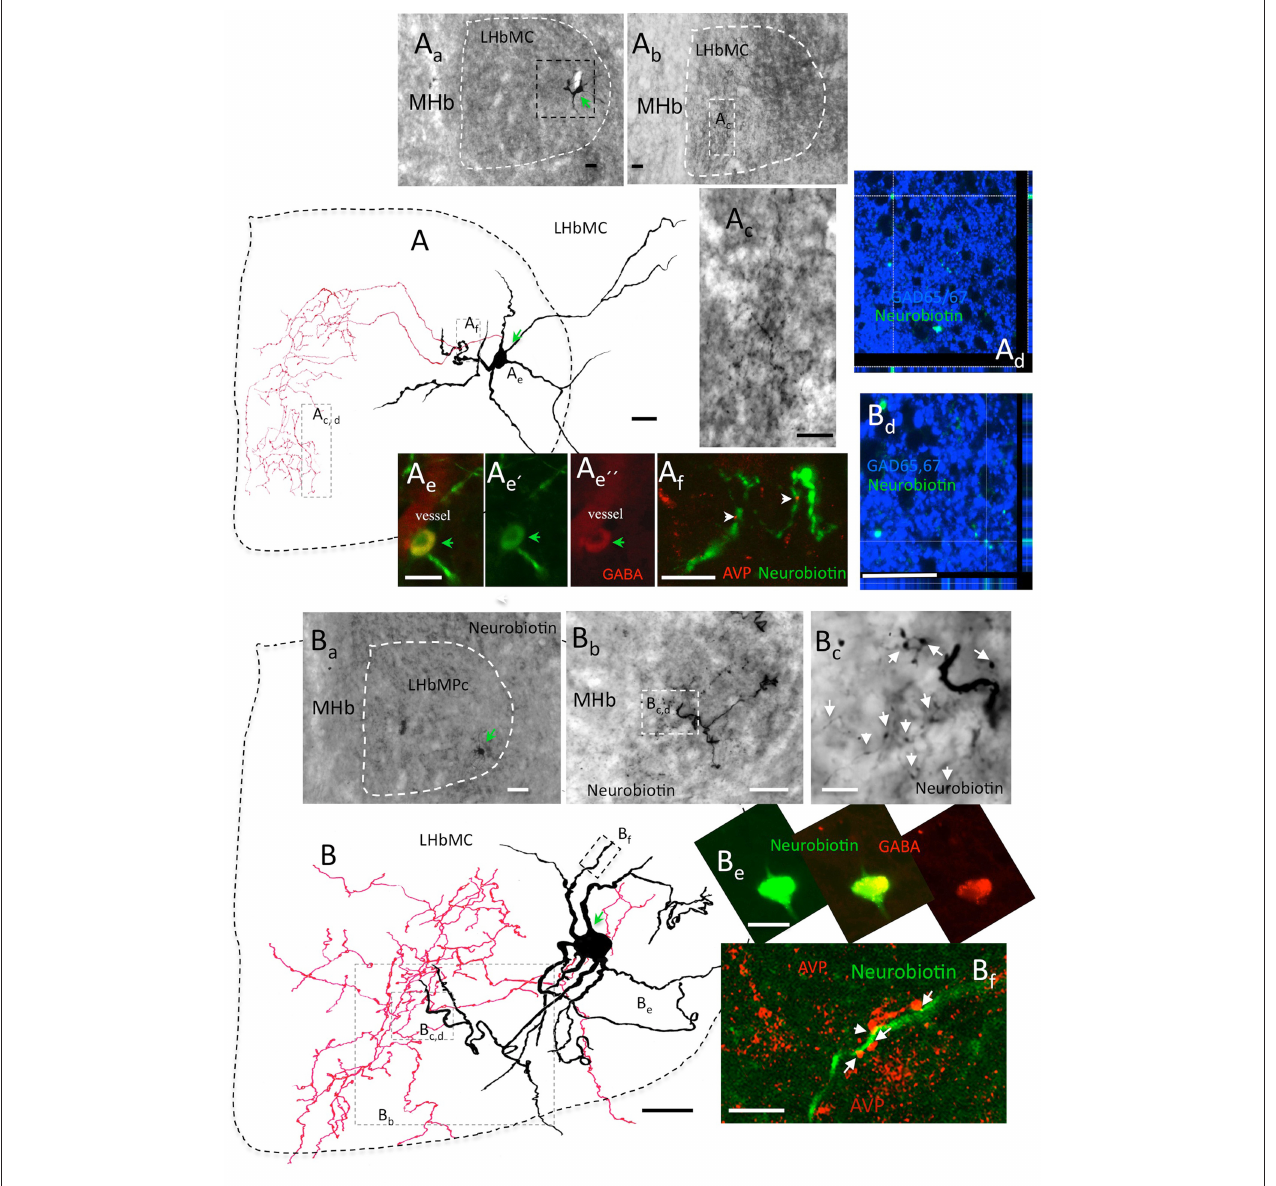
FIGURE 7 | In vivo juxtacellular labeled individual LHbMC cells confirmed the interneuron identity of GABA cells. (A) : a camera lucida reconstruction of a juxtacellularly labeled cells superimposing 8 coronal sections of 70 µ m, respectively. (A a ) The soma was located in the lateral part of the LHbMC, around Bregma (Br) − 3.84mm, according to Rat Brain Atlas (Paxinos and Watson, 2006). (A b ) Labeled axons were concentrated around the rostro-caudal coordinate Br –3.48mm. (A c ) Is amplification of (A b ) squared region. (A e ) and (A d ) : The soma and axon terminals were tested immunopositive to GABA and Gad 65/67, respectively. (Af) : A close contacting relationship was observed between the neurobiotin labeled dendrite and VP + axons. (B) : Another example of in vivo juxtacellularly labeled GABAergic interneuron. Camera lucida reconstruction was obtained from 10 coronal sections of 70 µ m, respectively. (B a ) Soma (B) was located in the lateral part of the LHbMC, around Br − 3.72mm. (B b ) The main axonal ramification was found in sections caudal to the soma. (B c ) is an amplification of the squared region of (B b ) . The axon was tested to be GAD65/67 + with confocal microscopy (B d ) while the soma was GABA + (B e ) . This cell’s dendrites were also contacting AVP + axons (B f ) . Scale bars: 20 µ